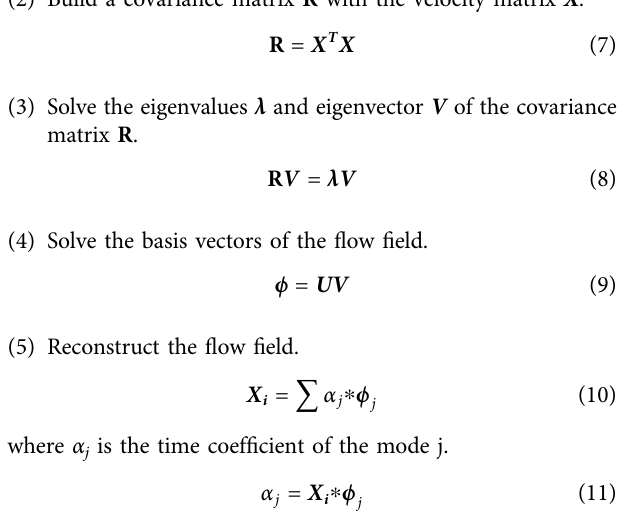
Frontiers in Energy Research |